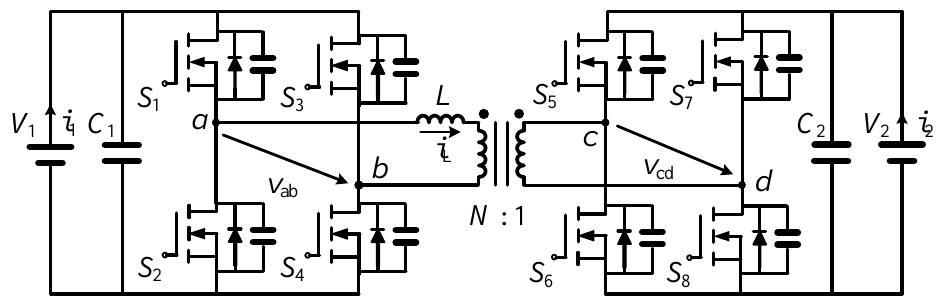
Figure 1. Configuration of the dual-active-bridge (DAB) converter.